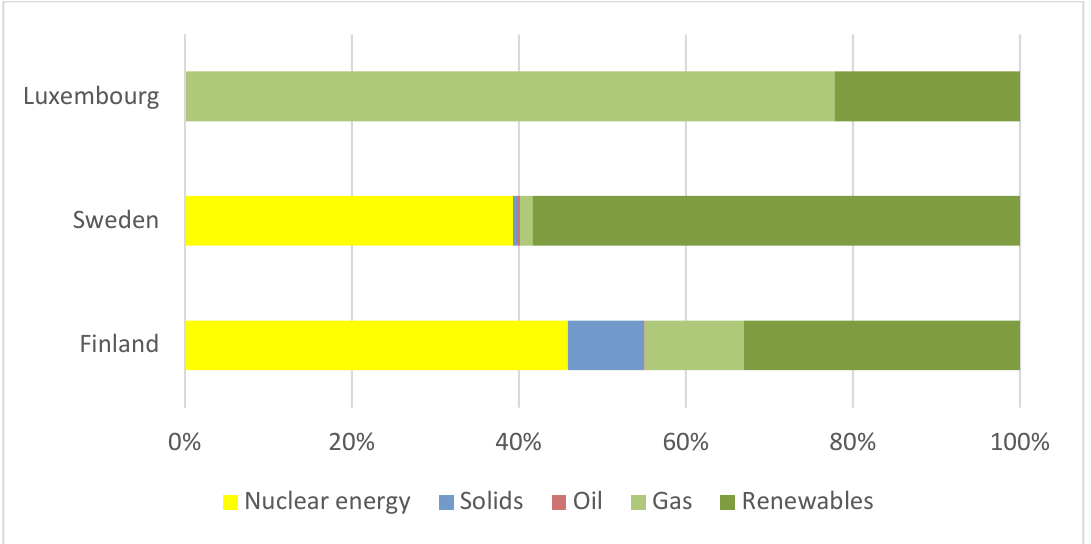
Figure 7. Structure of energy mixes for the first and second clusters. Source (own elaboration).